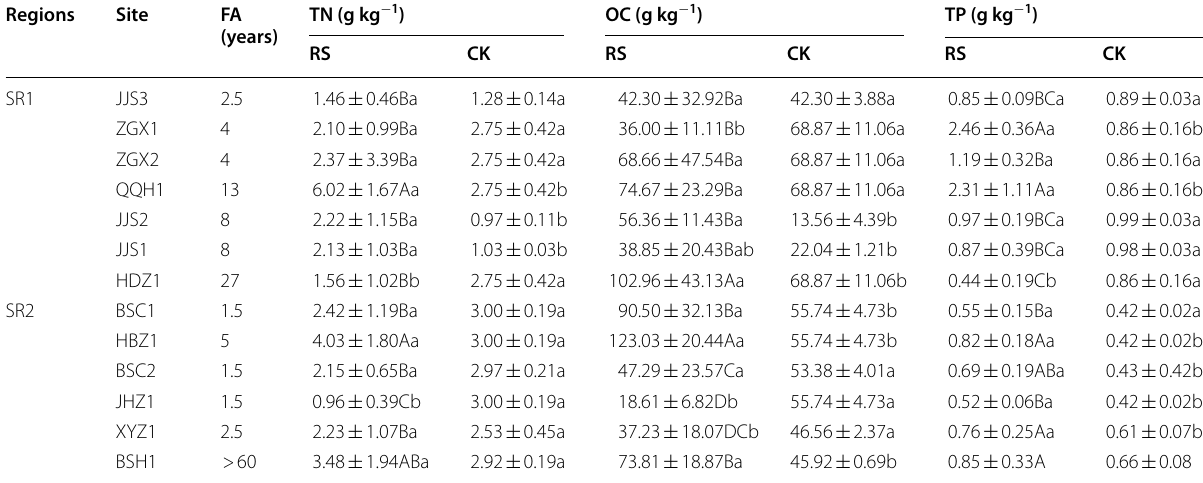
FA represents formation age of RCSs; RS and CK represent soils sampled on RCSs and natural slopes, respectively. The date of TN, OC, and TP are expressed in mean standard deviation. Within the same region, different lowercase letters represent the significantly different ( P < 0.05) in major soil nutrients between RS and ± CK, and different capital letters represent the significantly different ( P < 0.05) in major soil nutrients among different sites in the same region